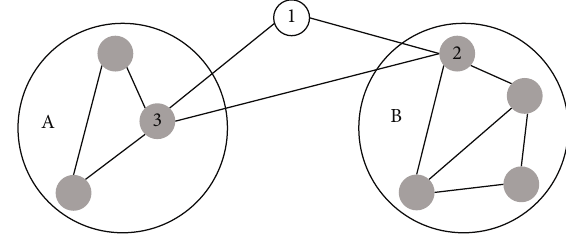
Figure 5: Isolated node with connected